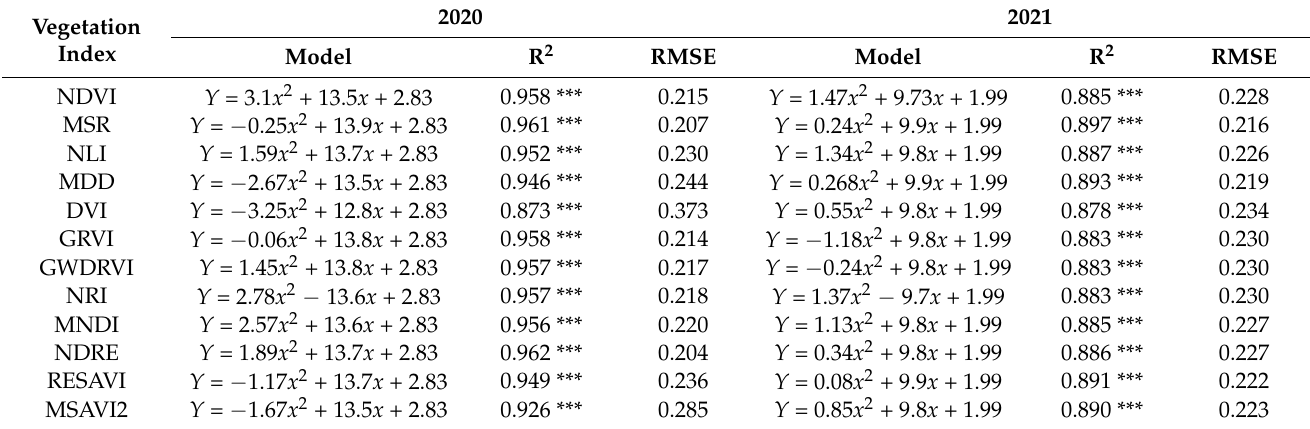
Table 6. Univariate polynomial regression model accuracy for UAV-based